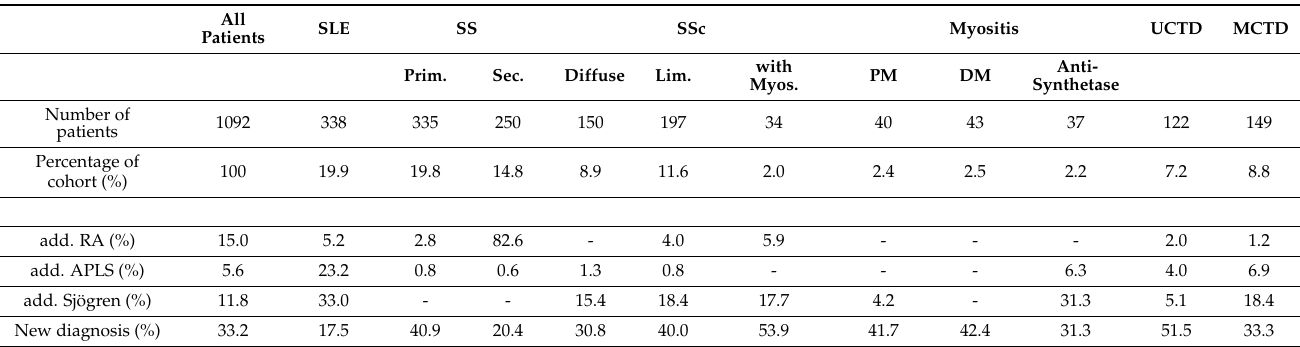
Table 1. Patient